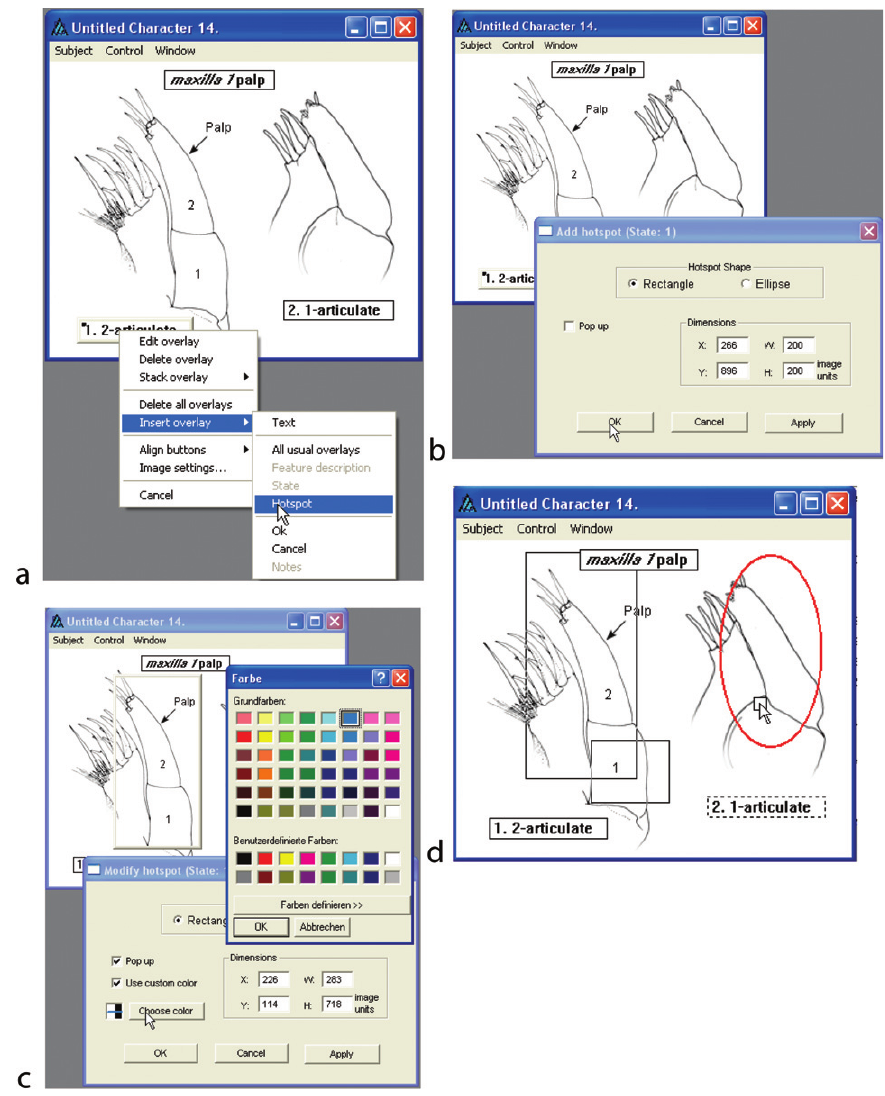
Figure 20a–d. Creating hotspots on a character image. Hotspots are areas of the image that are linked to the state-text boxes. In Intkey, they assist in the identifi cation and selection of character states. More than one hotspot may be associated with any state, and they may be invisible or ‘pop-up’. When the cursor is moved over a hotspot, the associated state-text box becomes visibly active, and any associated pop-up hotspots become visible; the state may be selected by clicking on the hotspot. Conversely, when the cursor is moved over a state-text box, any associated pop-up hotspots become